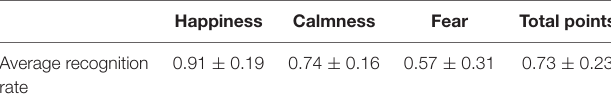
TABLE 4 | Development of children’s emotion recognition